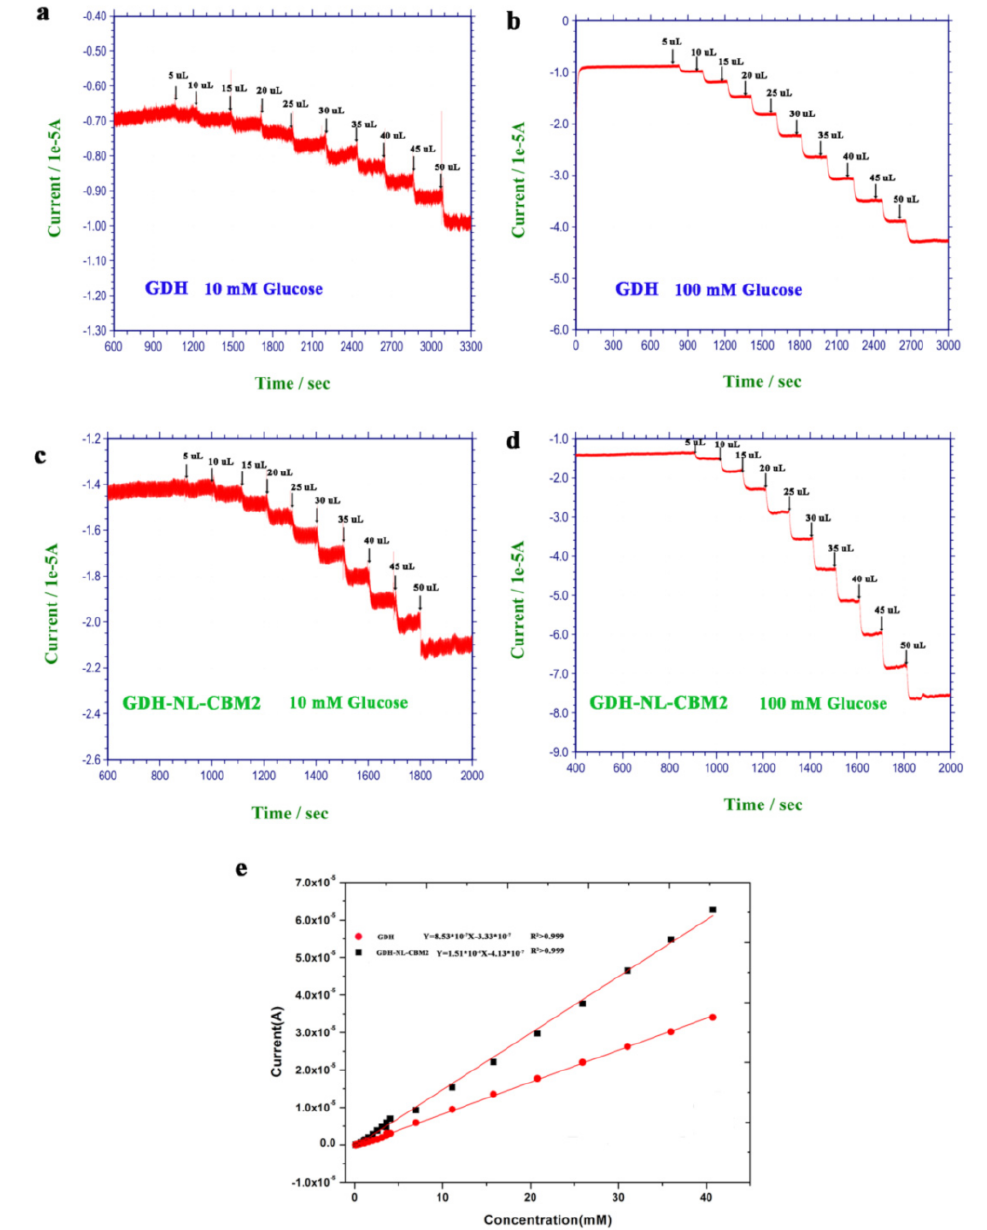
Figure 6. Time–current response of the GA/CS/GDH/S-MWCN/GCE and GDH-NL-CBM2/NC/S- MWNT/GCE electrodes for the sequential addition of 100 mM and 10 mM glucose at different volumes. ( a , b ) Addition of 10 mM and 100 mM glucose at different volumes for the GA/CS/GDH/S- MWCN/GCE, respectively; ( c , d ) Addition of 10 mM and 100 mM glucose at different volumes for the GDH-NL-CBM2/NC/S-MWNT/GCE, respectively; ( e ) Calibration plot for the glucose response using the data in ( a – d